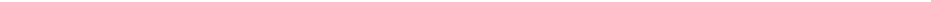
Symbol ✓ indicates that this kind of model was used in the study, and the numbers between brackets indicate the rank of the model (if this was included in the study)